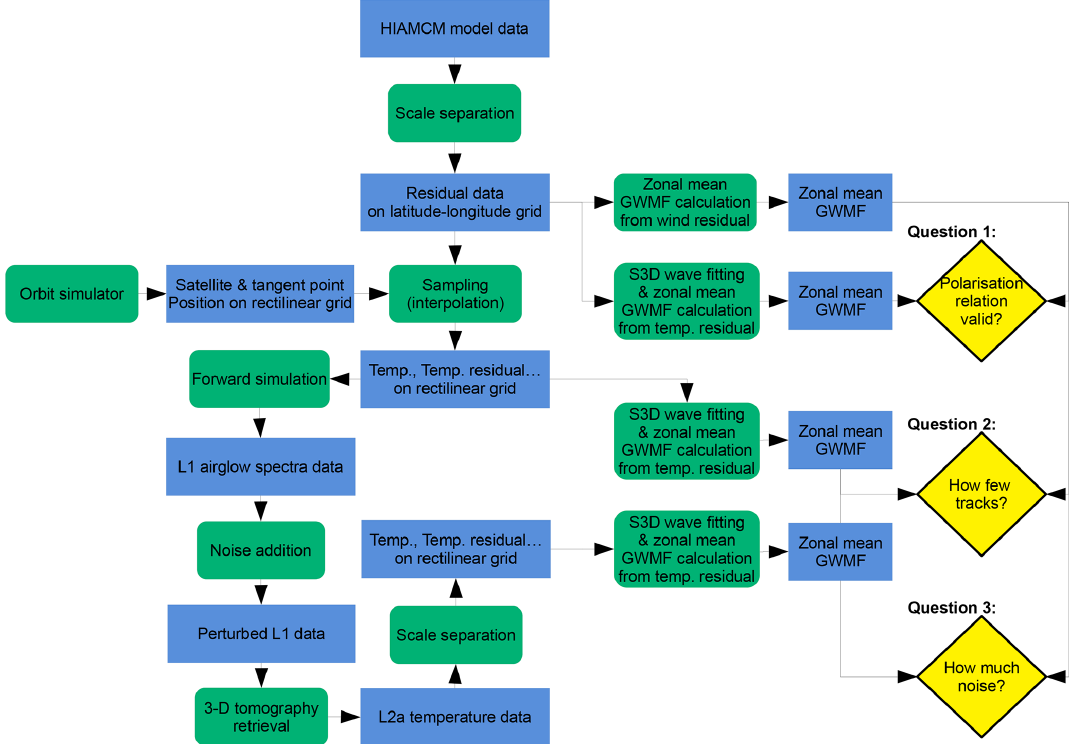
Figure 2. Schematic flow diagram of the assessment steps to address the three major questions highlighted in yellow diamond boxes. The assessment is based on comparison with zonal mean GWMF calculated directly from the model winds and considered here as the reference of truth. From the top down further assumptions and/or constraints are added as the tested data become more similar to the real observations.